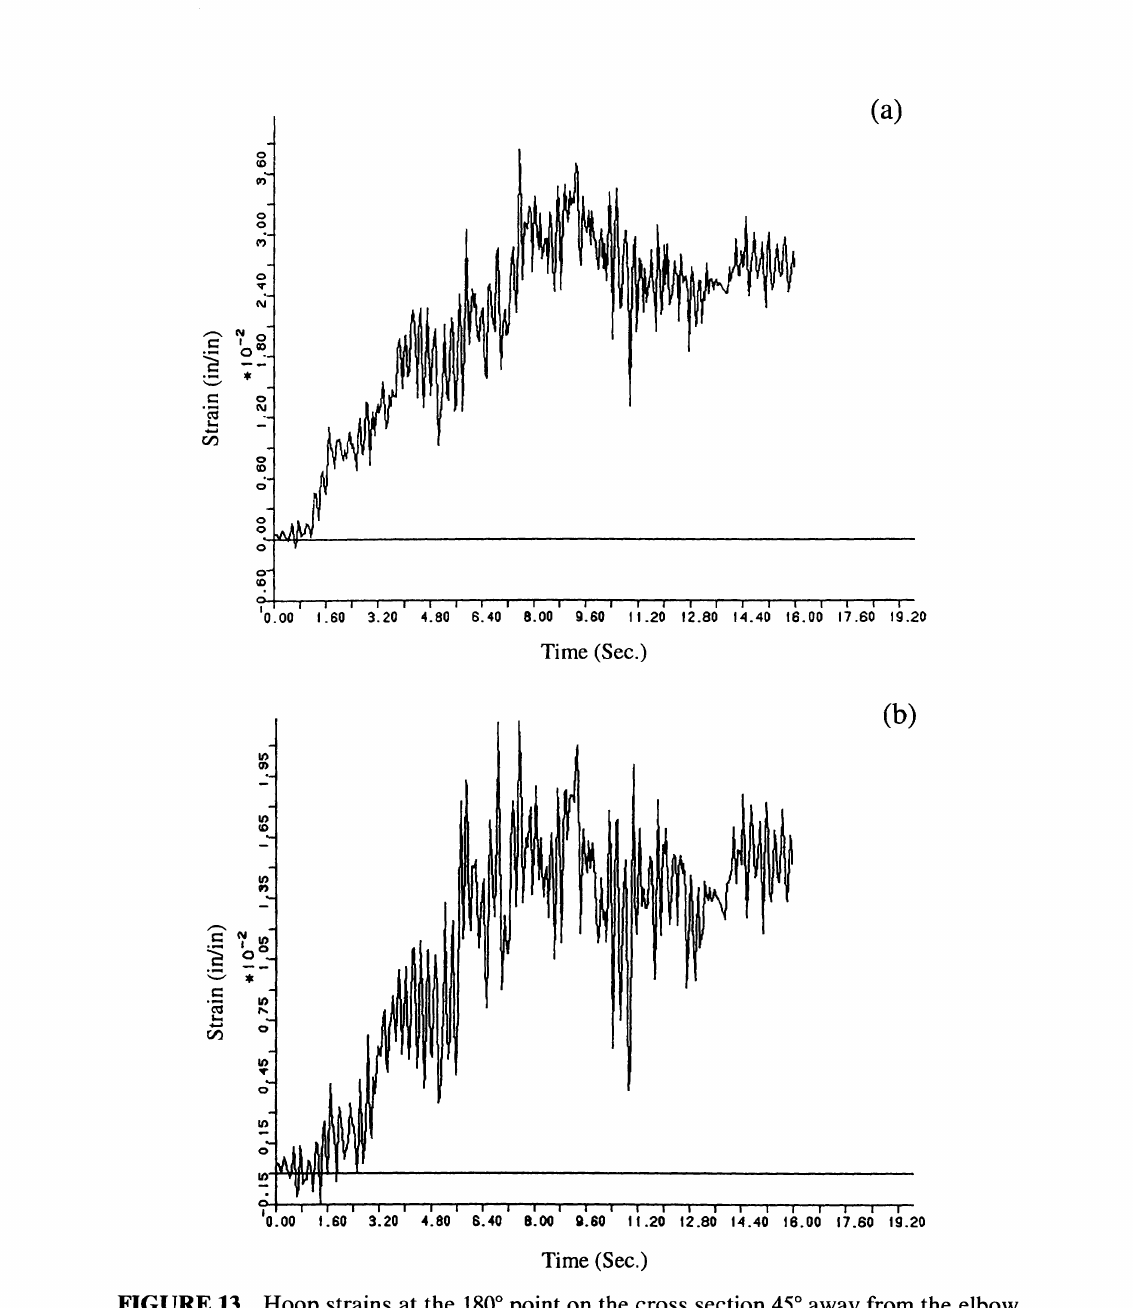
FIGURE 13 Hoop strains at the 180 0 point on the cross section 45 0 away from the elbow end (a) when yield stress equals 35 ksi and (b) when tangent modulus is reduced two